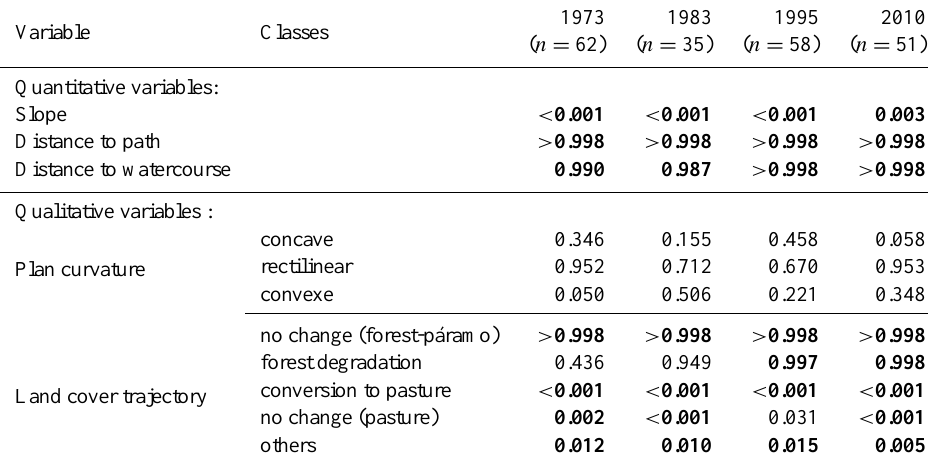
Table 2. Exceedance probabilities of the landslide inventories of 1973, 1983, 1995 and 2010 for the 11 potential explanatory variables. The values that are significant at 5% are highlighted in